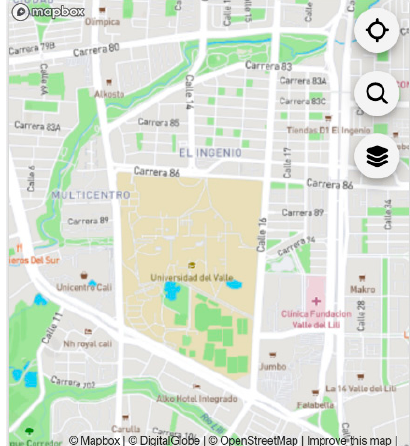
Figure 4. Mapbox Streets.